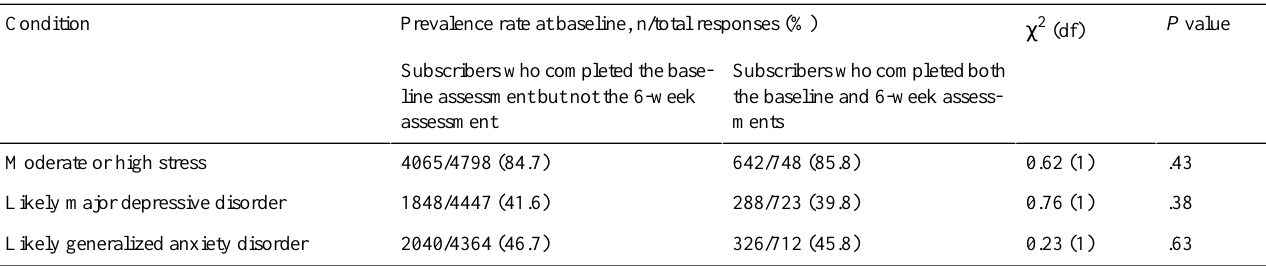
Table 4. Comparison of the prevalence rates of moderate or high stress, likely generalized anxiety disorder, and likely major depressive disorder between subscribers who only completed the baseline survey and subscribers who completed both the baseline and 6-week surveys.